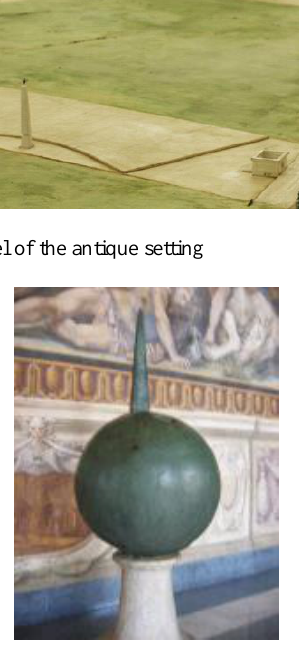
Figure 3: Imperial bronze ball from a Roman obelisk in the Capitoline